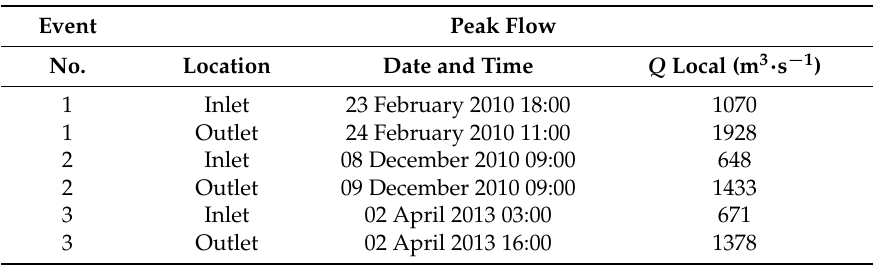
Table 1. Peak river discharges at Meng í bar (inlet) and Marmolejo (outlet) dams in February 2010, December 2010 and April 2013